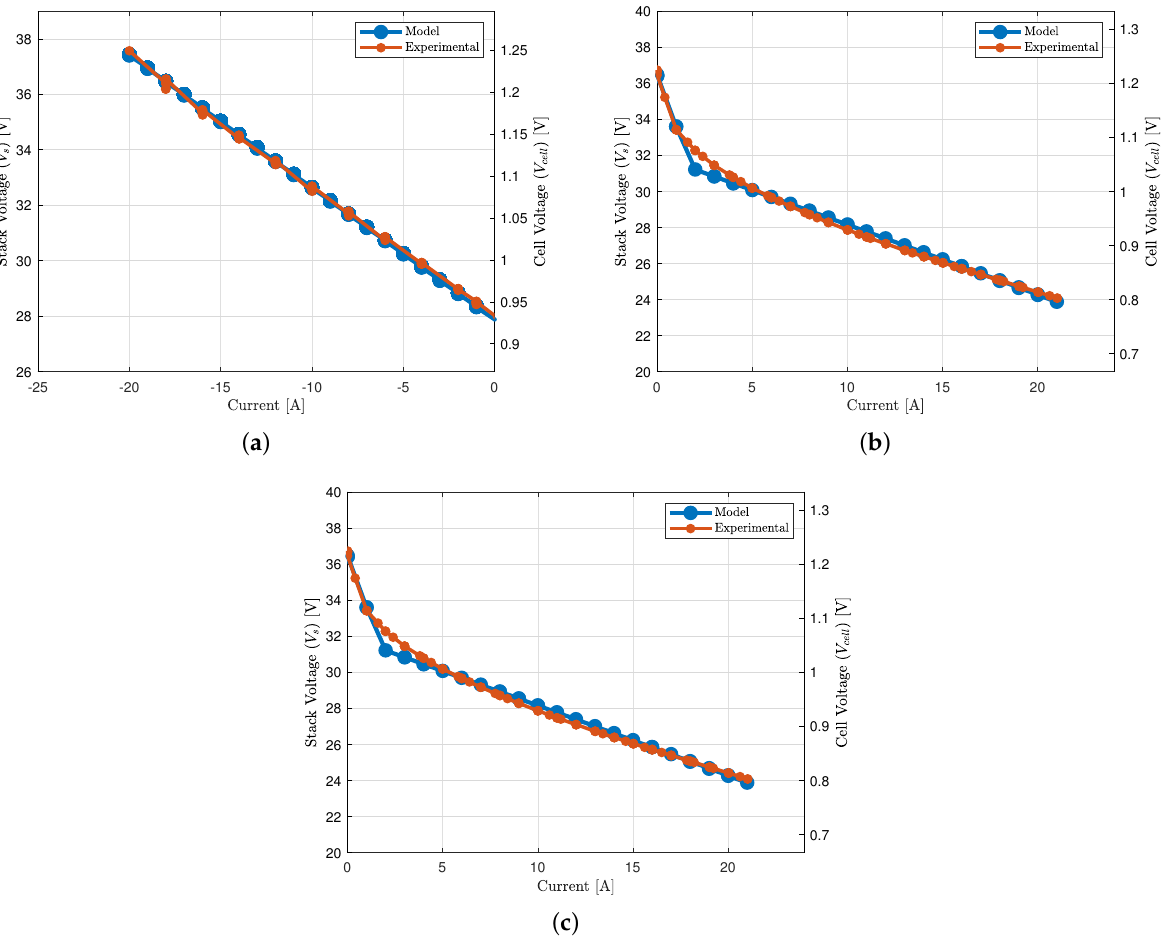
Figure 3. Polarization curves. ( a ) Electrolysis mode polarization curve keeping a constant fuel composition with a ratio of 70% of H 2 O and 30% of H 2 . ( b ) Fuel cell mode polarization curve keeping a constant fuel composition with a ratio of 100% of H 2 . ( c ) Reversible mode polarization curve keeping a constant fuel composition with a ratio of 50% of H 2 O and 50% of H 2